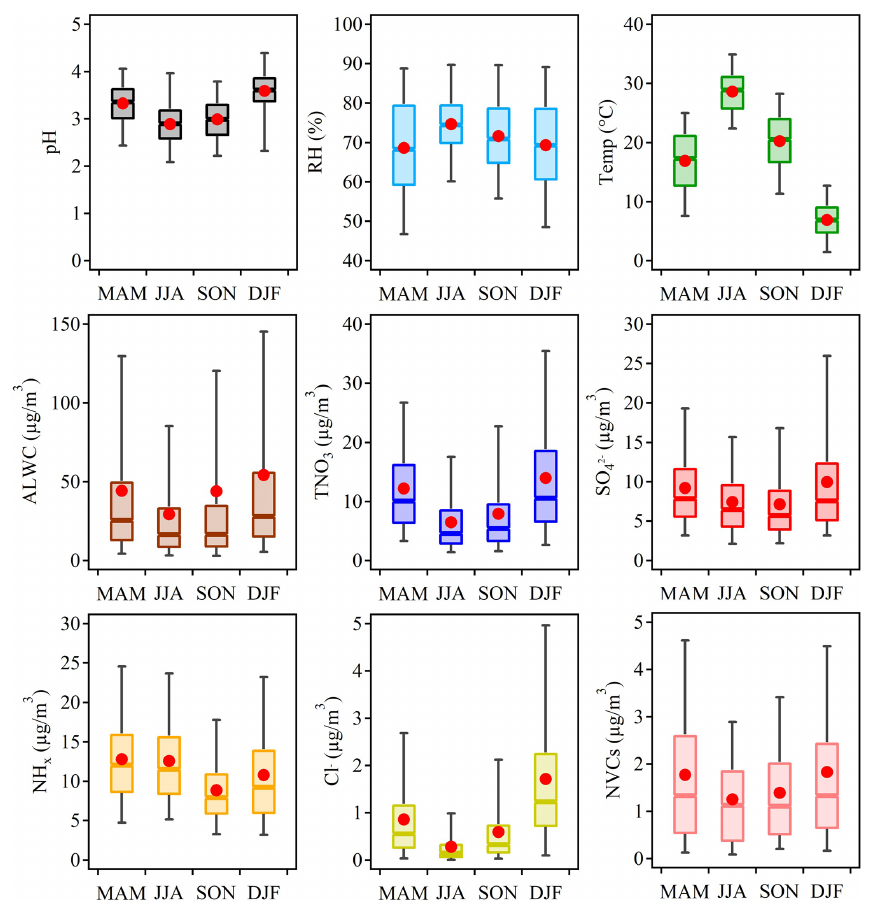
Figure 2. Seasonal variations of the mass concentrations of major components in PM 2 . 5 , relative humidity (RH), temperature (Temp), predicted aerosol liquid water content (ALWC) and aerosol pH during 2011–2019 in Shanghai.